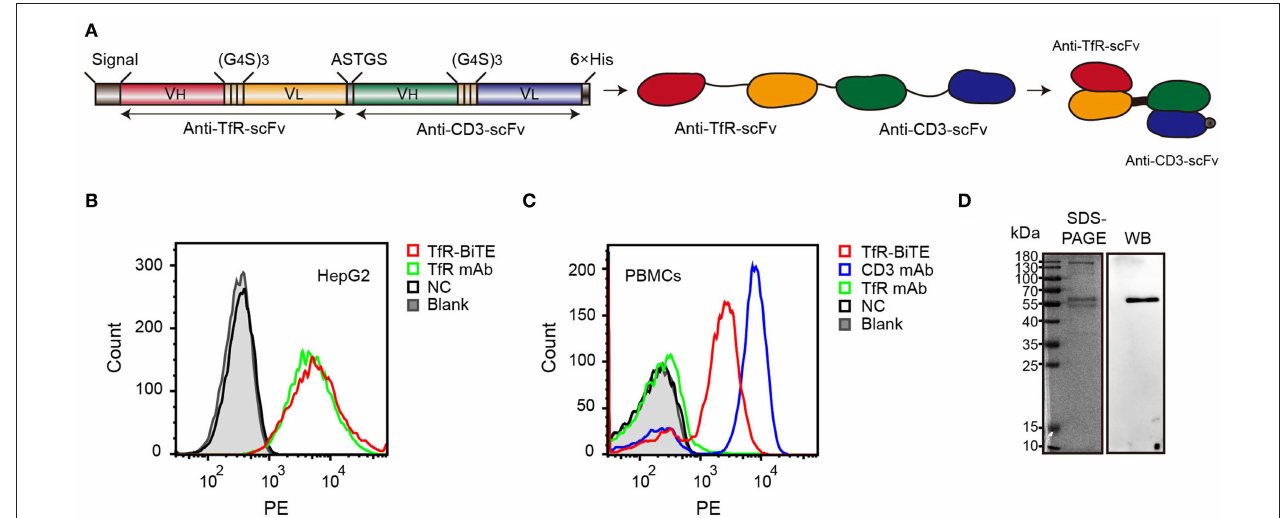
FIGURE 1 | Identification of TfR-BiTE. (A) Schematic representation of the TfR-BiTE constructs. Each scFv was composed of immunoglobulin variable heavy chain (V H ) and immunoglobulin variable light chain (V L ) domains, which were linked by a 15-residue peptide linker (G 4 S) 3 (light brown boxes). The silver box represents the short linker peptide (ASTGS), whereas the gray and black boxes represent the signal peptide and the 6 × His tag, respectively. (B,C) Binding of TfR-BiTE with HepG2 cells (TfR + ) and unstimulated PBMCs (TfR − and CD3 + ) were detected using anti-His tag mAb by flow cytometry analysis. PBS was set as the negative control (NC). (D) SDS-PAGE and Western blot analysis of TfR-BiTE. The migration distances of the molecular mass markers are indicated in kilodaltons